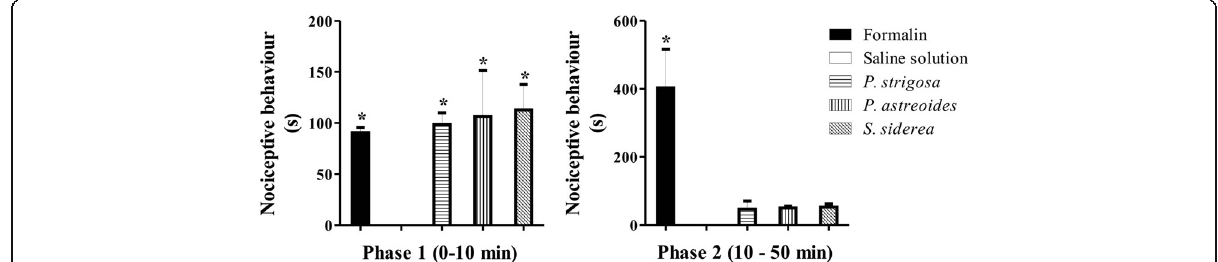
Fig. 4 Formalin test for assessment of the nociceptive activity of the extracts in rats at a dose of 40 μ g protein/paw. Nociceptive behavior in phase 1 (0 – 10 min post-injection) and phase 2 (10 – 50 min post-injection) was scored as the amount of time spent licking, flinching, and lifting.